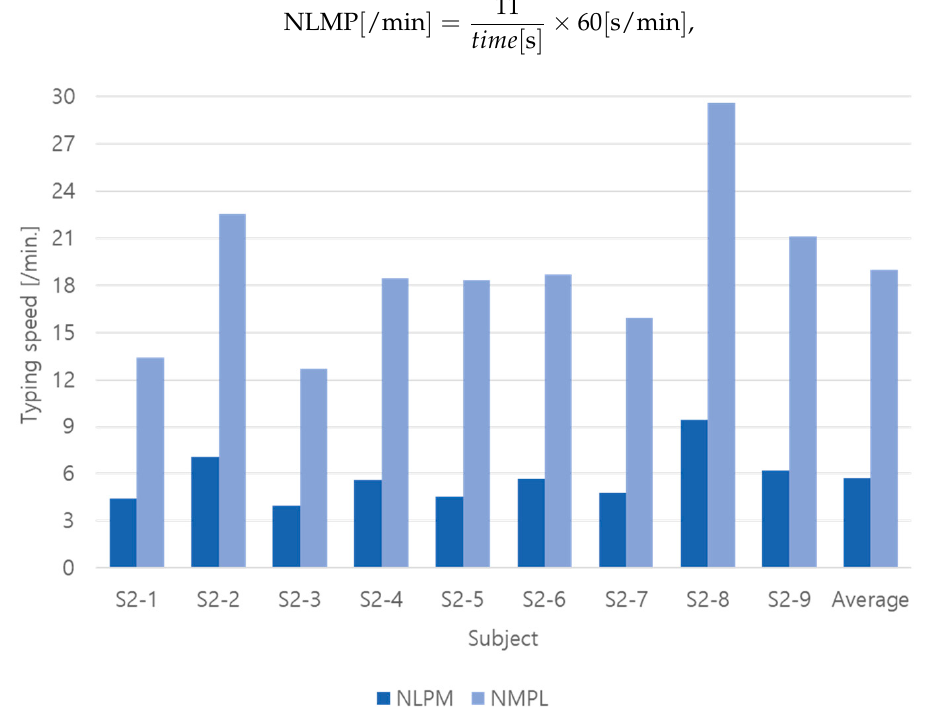
Figure 15. Comparison of typing speed per subject. Table 2. Typing speed per subject.